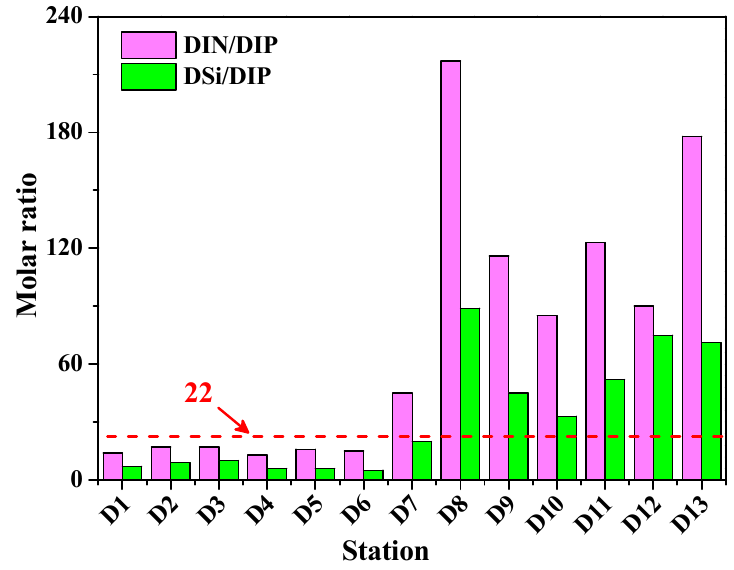
Figure 4. Distributions of nutrient molar ratios in surface waters of the Dafengjiang River estuary. Ambient molar ratios of DIN/DIP and DSi/DIP > 22 indicate stoichiometric (potential) P limitation for phytoplankton growth [51].